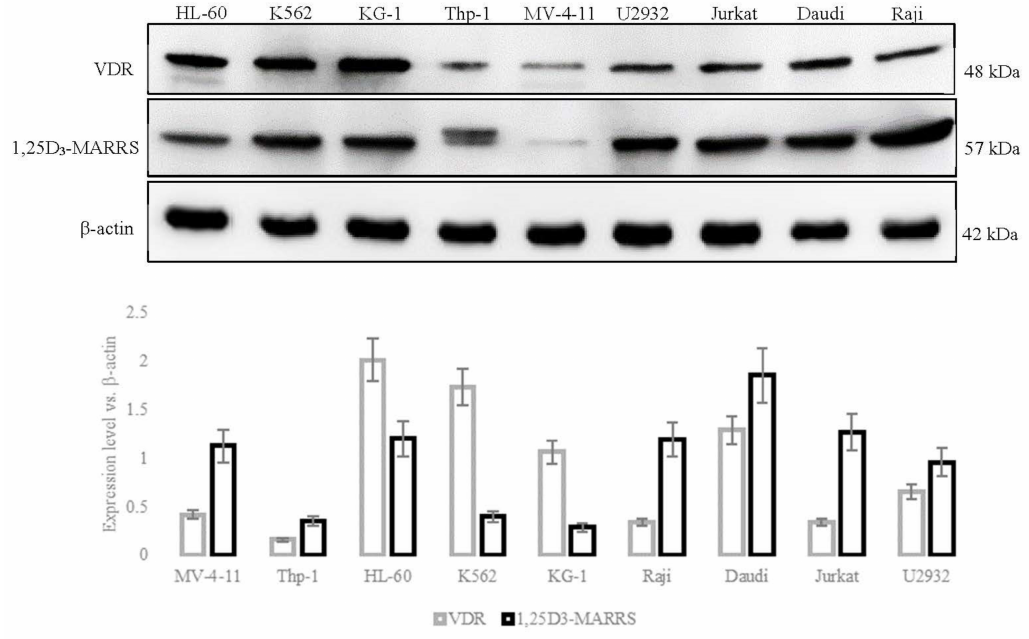
Figure 5. Protein levels of vitamin D-binding receptors: native VDR and 1,25D3-MARRS in leukemia and lymphoma cells. Relative protein levels were estimated by densitometric measurements of VDR and 1,25D 3 -MARRS signals obtained by Western blotting, were normalized to β -actin (representative of Western blotting results above the plot). Whole Western blots result presented in Figure